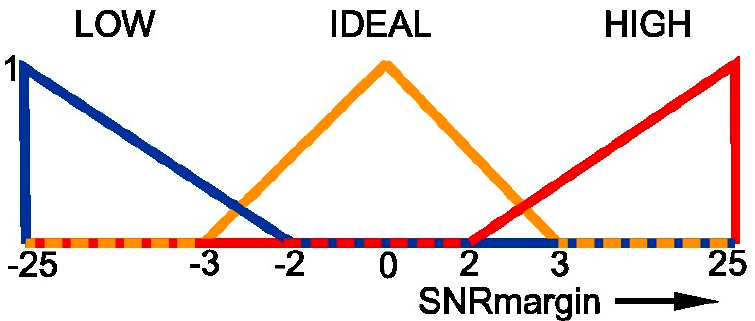
Figure 2. 𝑆𝑁𝑅 (cid:3040)(cid:3028)(cid:3045)(cid:3034)(cid:3036)(cid:3041) membership function. Figure 2. SNR margin membership